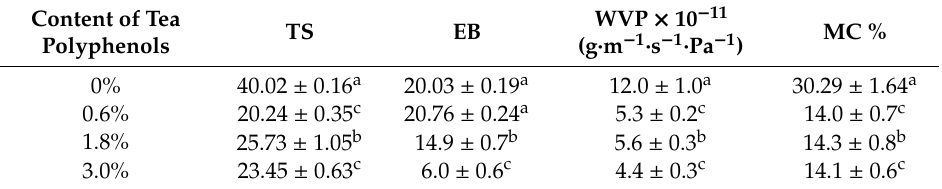
Table 2. TS, EB, WVP, and MC of curdlan / chitosan blended